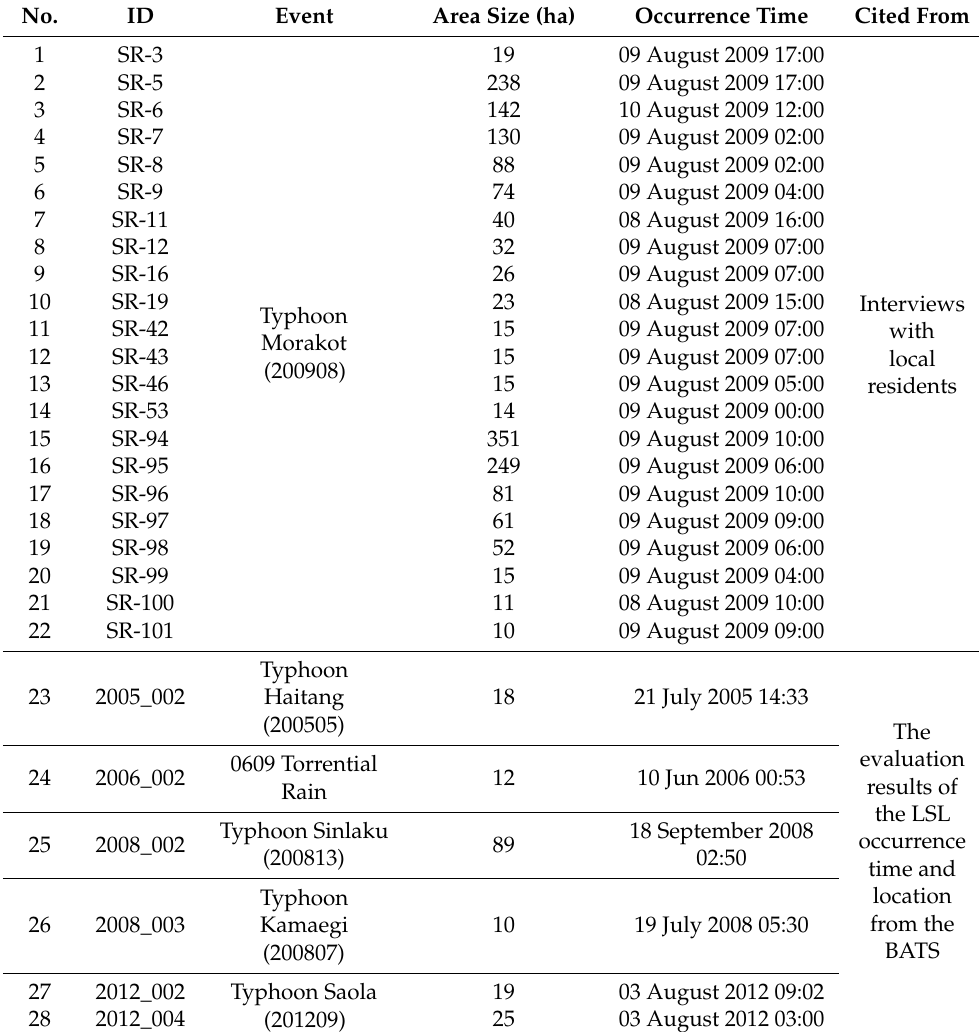
Table 2. Information of the 28 newborn